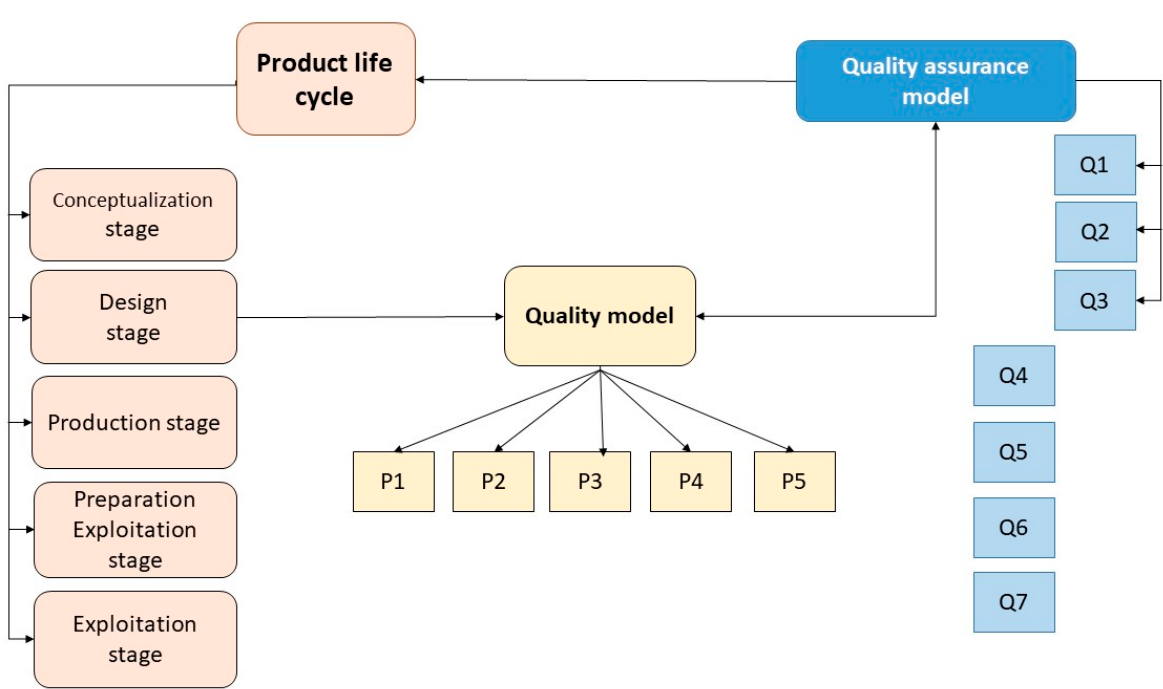
Figure 2. Product life cycle.